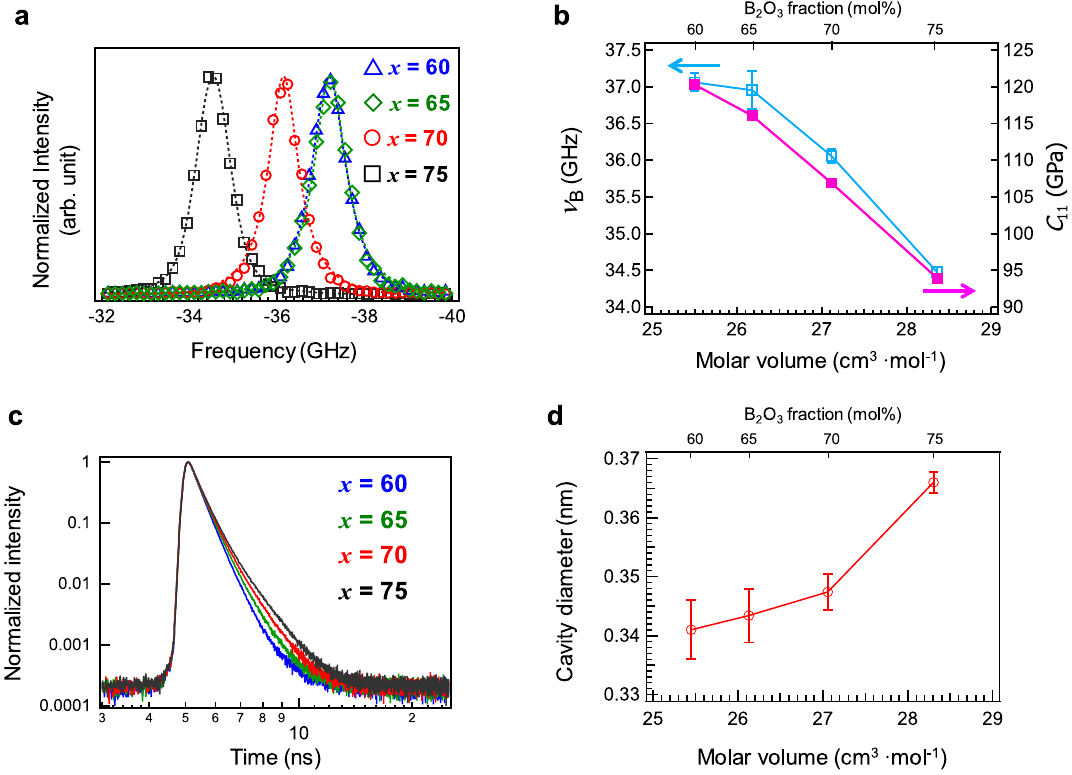
Figure 2. Dynamic structure factors of Ce:SBO x glasses. ( a ) Brillouin spectra of Ce:SBO x glasses. ( b ) ν B and c 11 values of Ce:SBO x glasses as a function of molar volume ( V M ). ( c ) Positron decay curves of Ce:SBO x glasses. ( d ) Cavity diameter of Ce:SBO x glasses as a function of V M